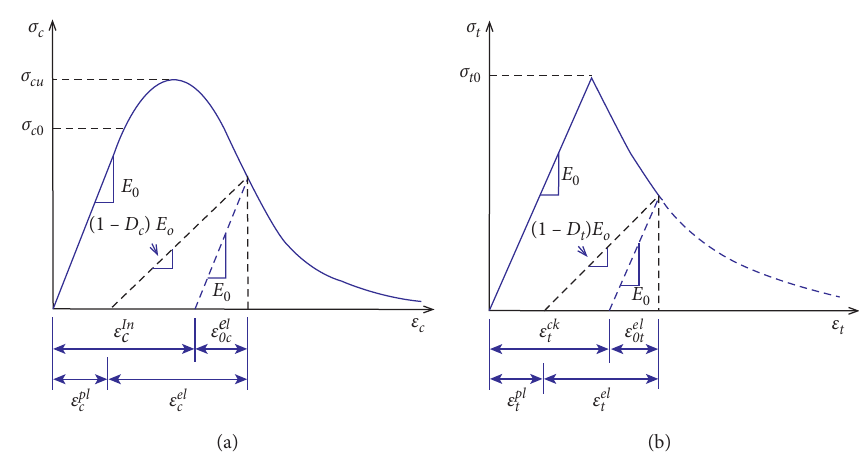
Figure 4: Concrete damage plasticity model: (a) compressive behavior; (b) tensile behavior [9].